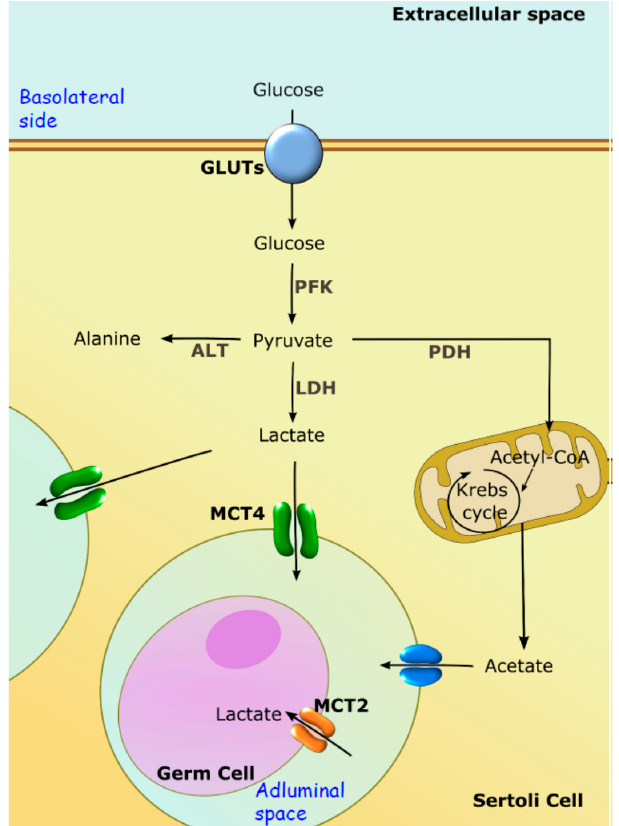
Figure 4. Schematic diagram of the metabolic cooperation between Sertoli cells (SCs) and developing germ cells. The glucose taken up from the extracellular space enters SCs through glucose transporters (GLUTs). The glucose is then converted to pyruvate through glycolysis. Pyruvate can follow multiple pathways. However, in these cells, most glucose is used to produce, via lactate by lactate dehydrogenase (LDH). Lactate is then transported out of SCs by specific monocarboxylate transporters (MCT4). Germ cells take up the lactate produced by SCs through MCT2. Of note, as happens in other cells, pyruvate can also be converted into alanine (by alanine aminotransferase—ALT) or transported to mitochondria, forming acetyl-CoA (by pyruvate dehydrogenase—PDH). Acetyl-CoA is then converted into acetate that may be used by germ cells for lipid synthesis. PFK, phosphofructokinase. In SCs, glucose crosses the plasma membrane through specific Glucose transporters